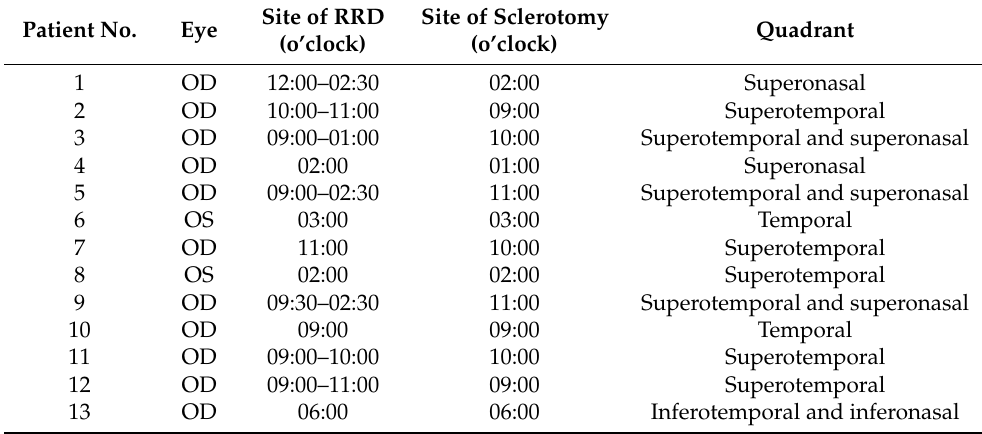
Table 2. Site of segmental scleral buckle implantation. Patient